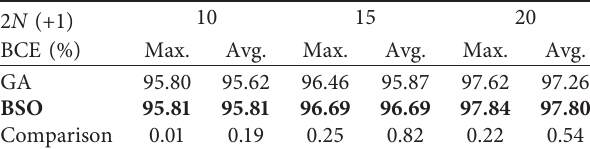
Table 4: Maximum and average BCE in BSO and